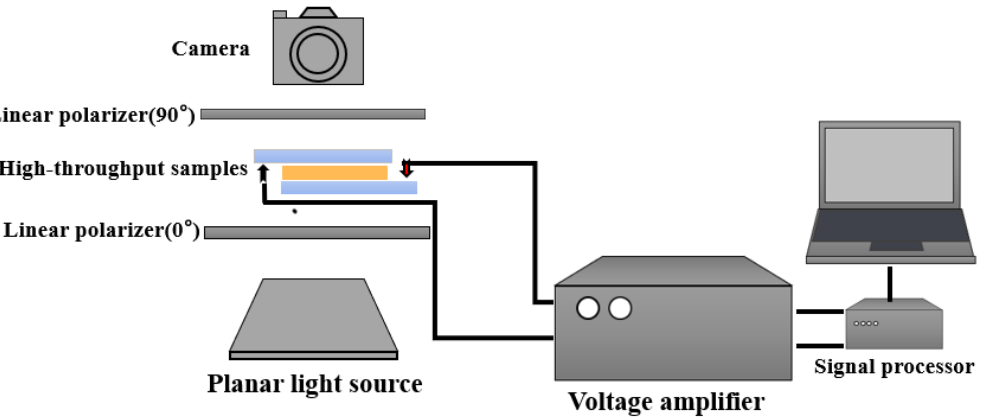
Figure 3. Device for high-throughput detection of LC samples.